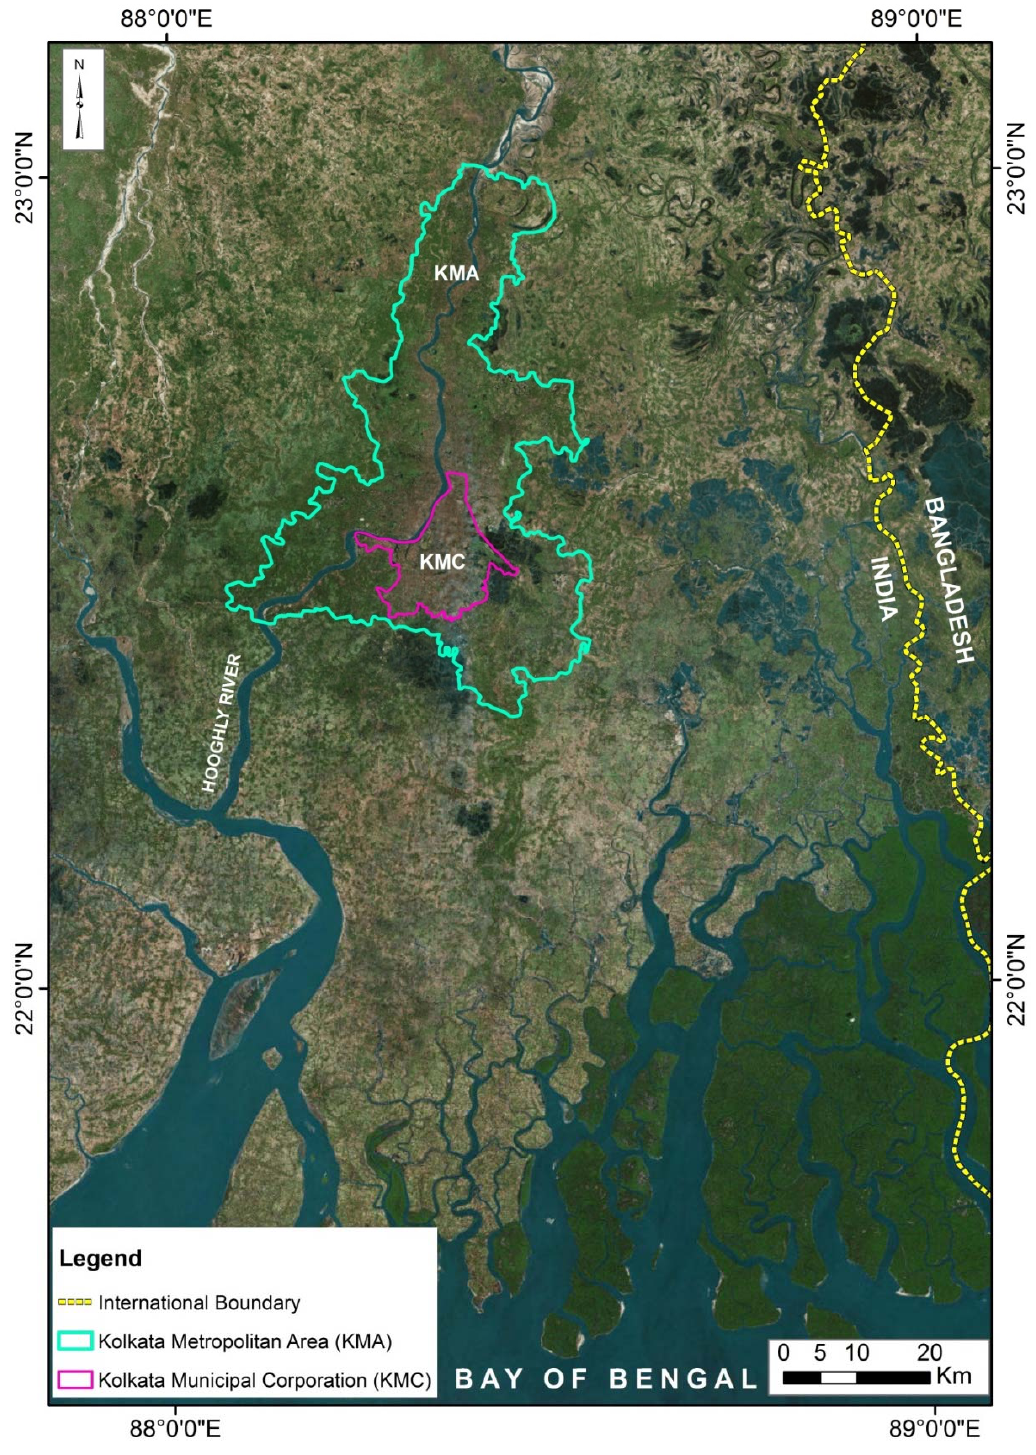
Figure 2. Map showing Kolkata Municipal Corporation area (KMC) and Kolkata Metropolitan Area (KMA) located within the vicinity of the coast and close to the international border of Bangladesh (Source: Kolkata Municipal Corporation, 2017, Google Map: Google Corporation Pvt Ltd, California, CA, United States., 2018).